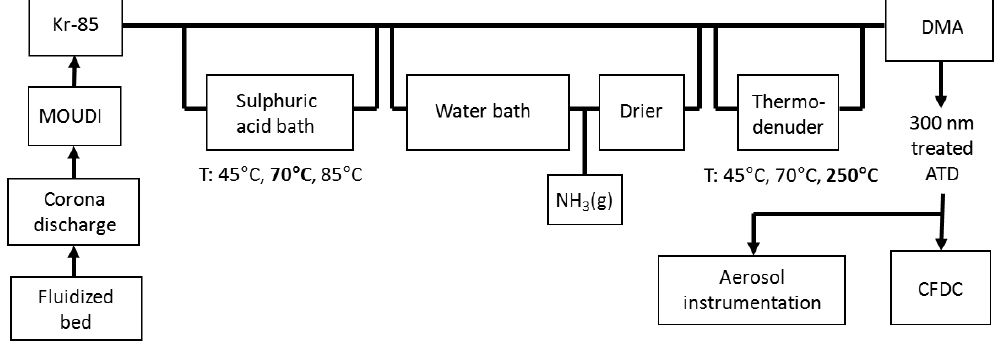
Figure 1. Schematic of dust aerosol generation, treatment, and analysis system. Arizona test dust was generated dry from the fluidized bed, and then subjected to a variety of thermochemical treatment options. The most commonly used sequence of treatment options is shown here. Temperatures listed in bold were the default settings used in the sulphuric acid coating oven and thermodenuder. A differential mobility analyser (DMA) selected 300nm mobility diameter particles after treatment for analysis by the CFDC and other instruments including the ATOFMS, AMS, and CCNc.